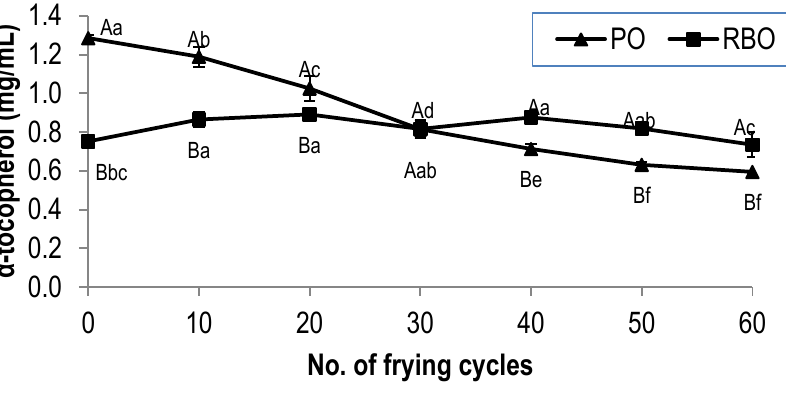
Figure 2. The degradation of α-tocopherol in palm oil and rice bran oil during deep-frying. The values given are means ± standard deviation of triplicate analysis. The values marked with the same letters are not significantly different at p < 0.05 analyzed using the Duncan multiple range test. A,B, the values with different capital letters indicate a significant difference between the type of oil at p < 0.05. a,b, the values with different small letters indicate a significant difference between frying cycle numbers at p <